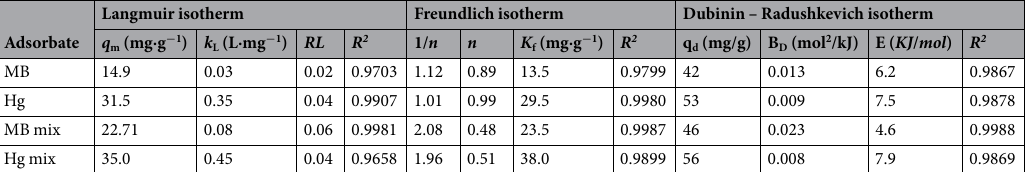
Table 3. Langmuir and Freundlich isotherms data for adsorption by HCPZA 9